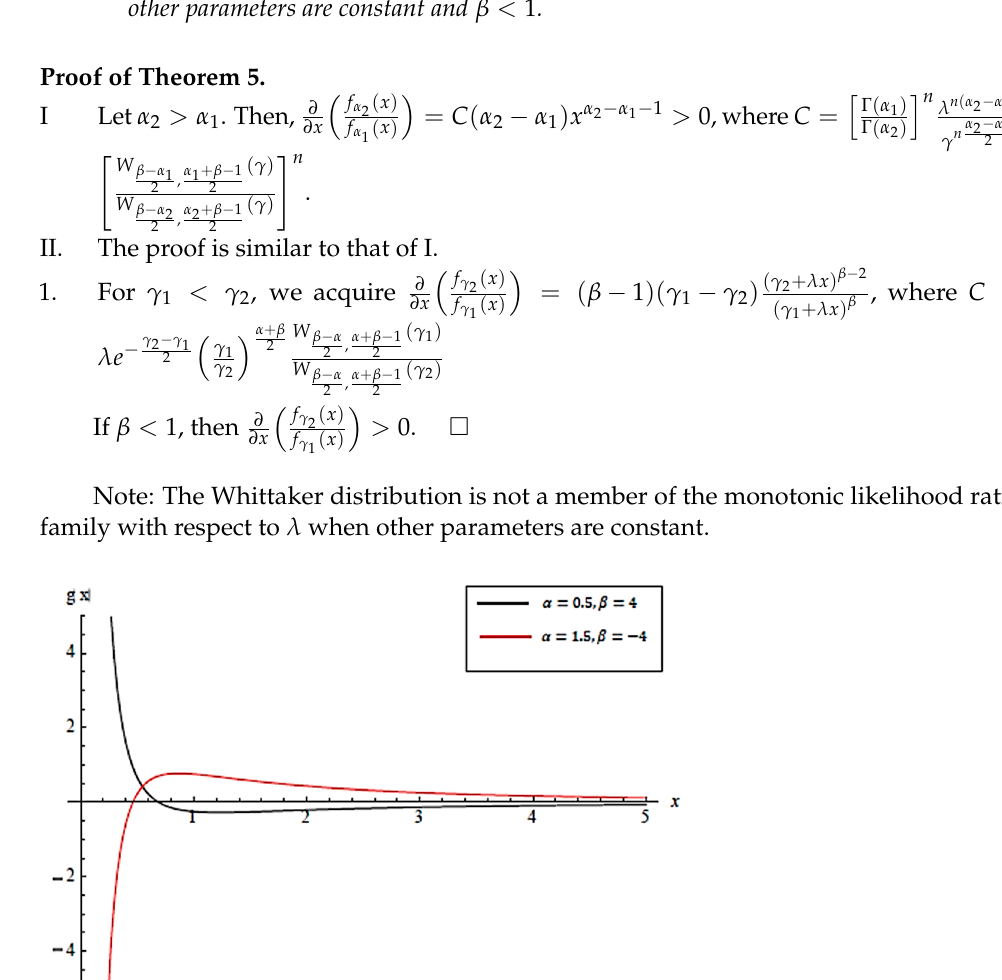
Figure 3. g ( x ) for WD ( 0.5,4,1,1 ) , and WD ( 1.5, − 4,1,1 ) . Figure 3. 𝑔(𝑥) for 𝑊𝐷(0.5,4,1,1), and 𝑊𝐷(1.5,−4,1,1) . The distributions with log-concave density are unimodal and have increasing failure rate property.